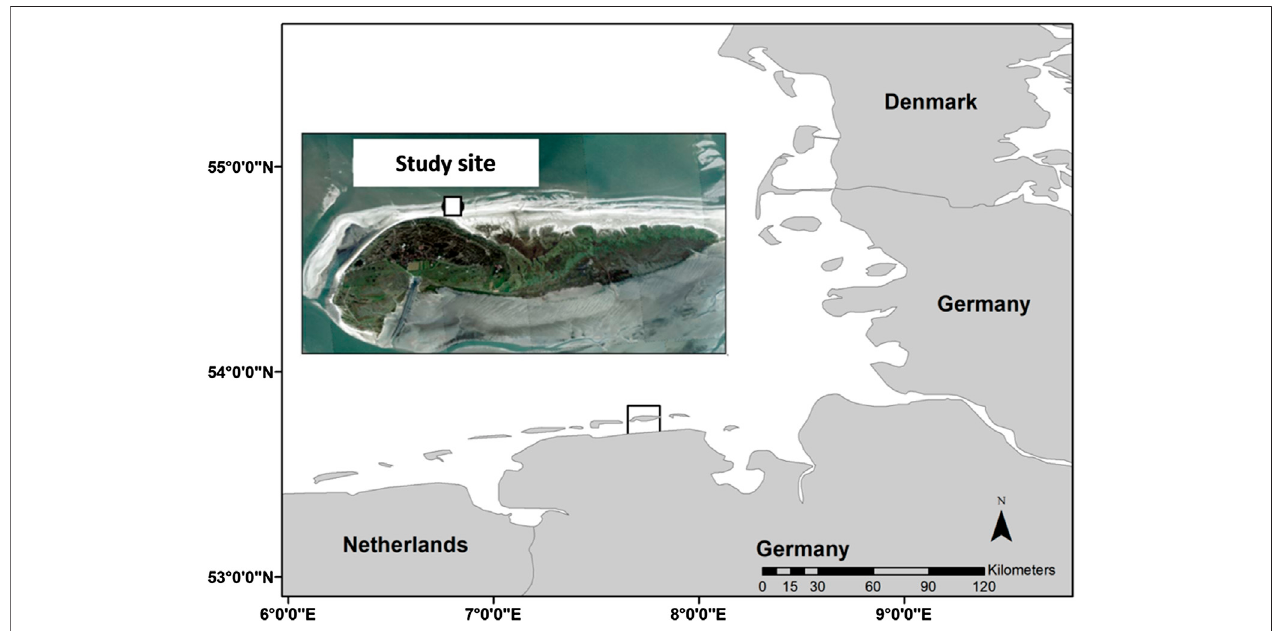
FIGURE 1 | Location of the fi eld site. The aerial picture was provided by the NLPV (2011).